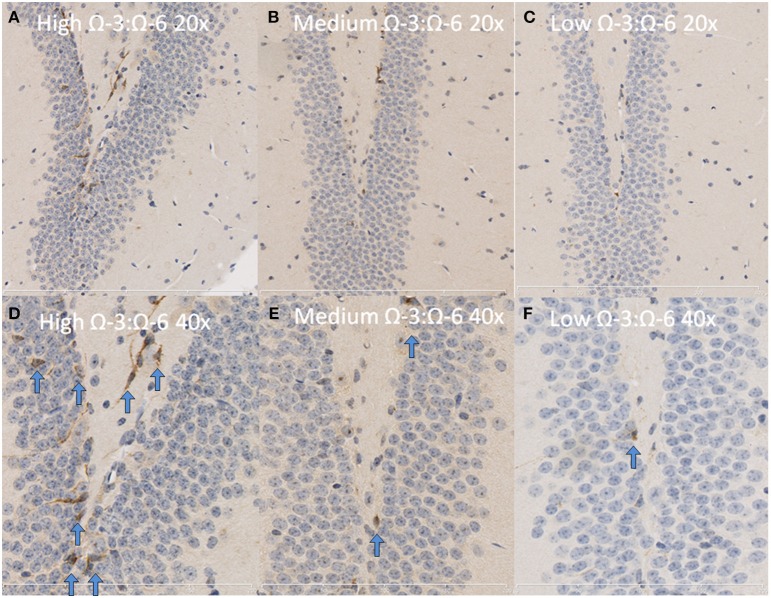
Representative images of DCX expression in the dentate gyrus. Representative images of the hippocampus centered on the dentate gyrus to demonstrate expression of DCX positive cells at 20× magnification in (A) high Ω-3:Ω-6 mice, (B) medium Ω-3:Ω-6 mice, (C) low Ω-3:Ω-6 mice and at 40× magnification in (D–F), respectively. Arrows signify relevant stained cells.